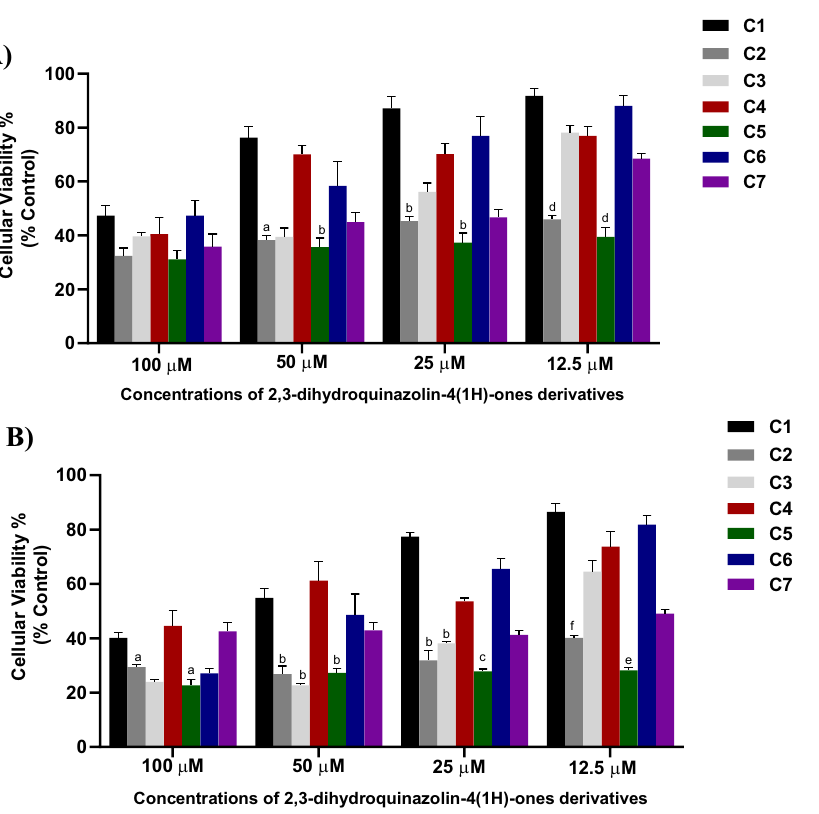
Figure 2. The antiproliferative activities of the seven 2,3-dihydroquinazolin-4(1 H )-one analogues (C1–C7) against PC3 ( A ) and DU145 ( B ). a Significant difference in comparison to C1 and C4. b Significant difference in comparison to C1, C4, C6. c Significant difference in comparison to C1, C4, C6 and C7. d Significant difference in comparison C1, C3, C4, C6 and C7. e significant difference in comparison to all compounds except C2. f significant difference in comparison to C1, C3, C4 and C6. One-way ANOVA analysis using Tukey’s post hoc test was used to indicate significance ( P -value ≤